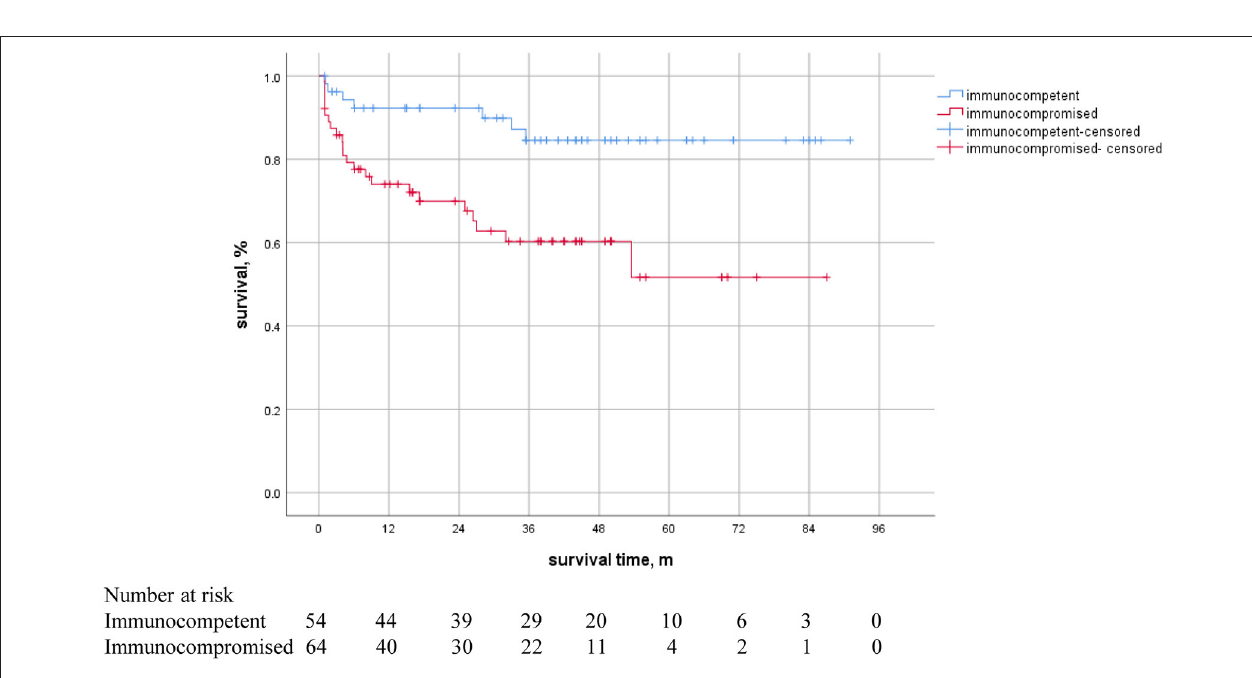
FIGURE 4 | Kaplan-Meier survival curves in NTM patients with or without immunosuppression. There was a statistically significant difference between the curves (HR 3.537, 95% CI 1.526–8.362, P =